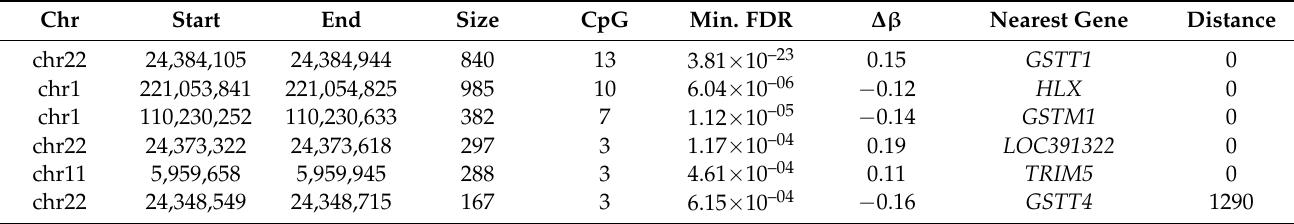
Table 2. Chromosomal regions with different methylation levels in sudden unexplained death compared to sudden unexpected death in epilepsy sorted by minimum false discovery